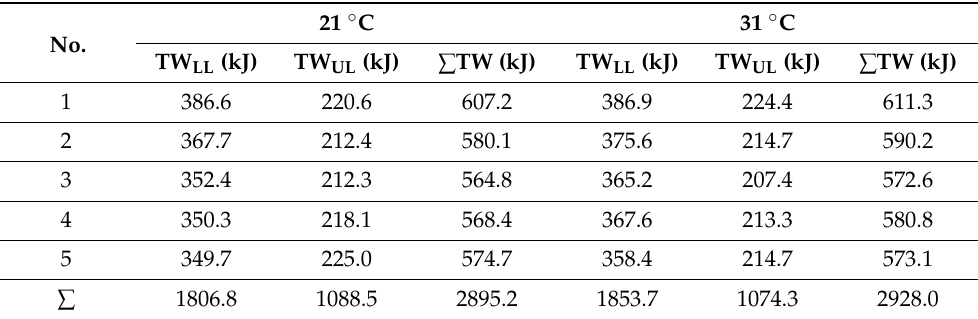
Table 4. Total work and its sum in the upper ( ∑ TW UL ) and lower limb ( ∑ TW LL ) tests during individual series of pulsating efforts and the global value of its sum ( ∑ T TW ) for pulsating efforts performed at 21 ◦ C and 31 ◦ C.